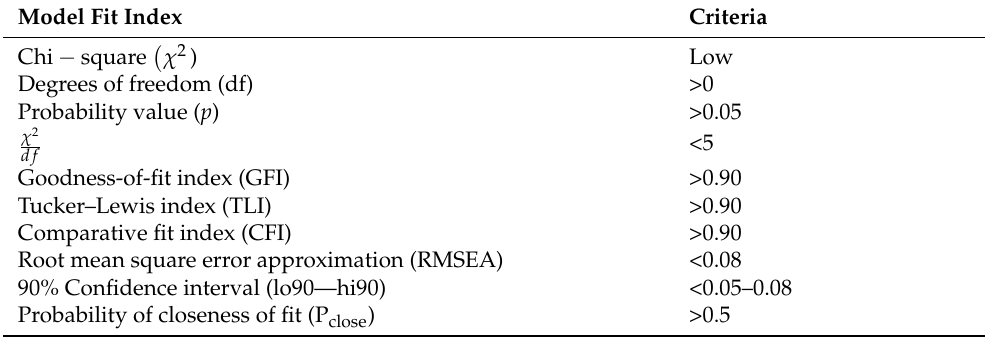
Table 3. Goodness of Fit Indices.